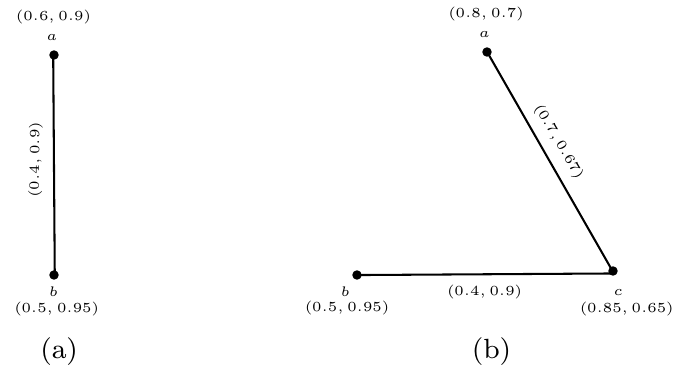
Figure 4. ( a ) 3-Rung Orthopair Fuzzy Subgraph; ( b ) Spanning 3-Rung Orthopair Fuzzy